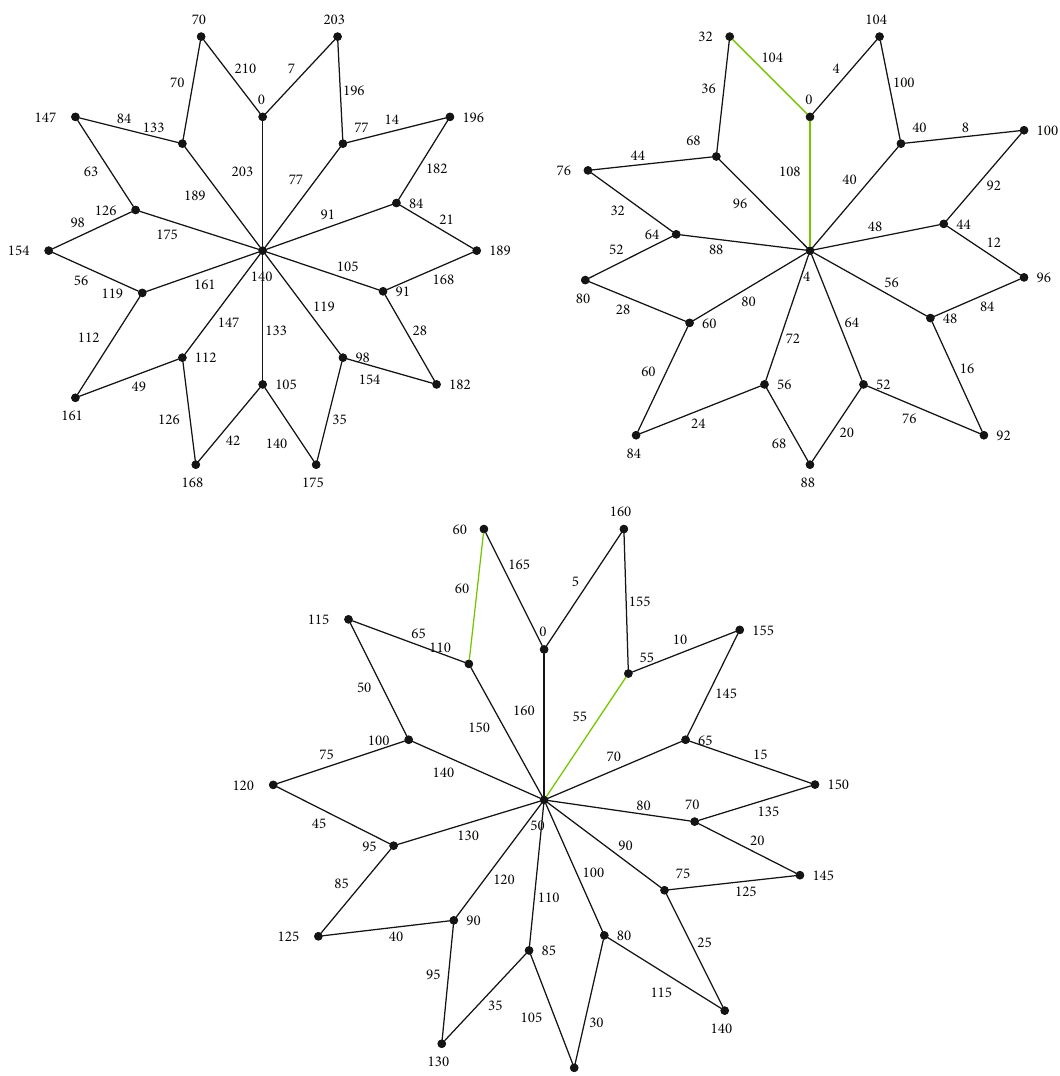
− graceful labeling, G 10 with edge 7